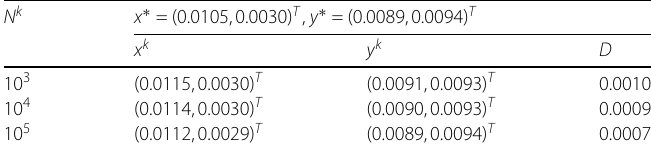
Table 1 Computational results for Example